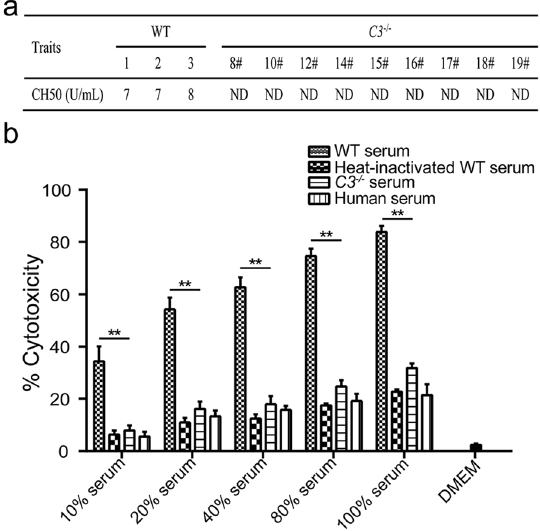
Figure 5. Hemolytic complement activity of pig serum and effects on anti-human cells. ( a ) Total hemolytic complement activities were determined by Dian Diagnostics. ( b ) The percentages of 293T cell lysis mediated by various concentrations of WT pig serum, heat-inactivated WT serum, C3 KO piglet serum, and human serum. Lysis of 293T cells was significantly reduced when incubated in serum of C3 KO piglets compared to WT controls. ( ** P < 0.01, data are shown as mean ± SEM, n = 5). ND: Not